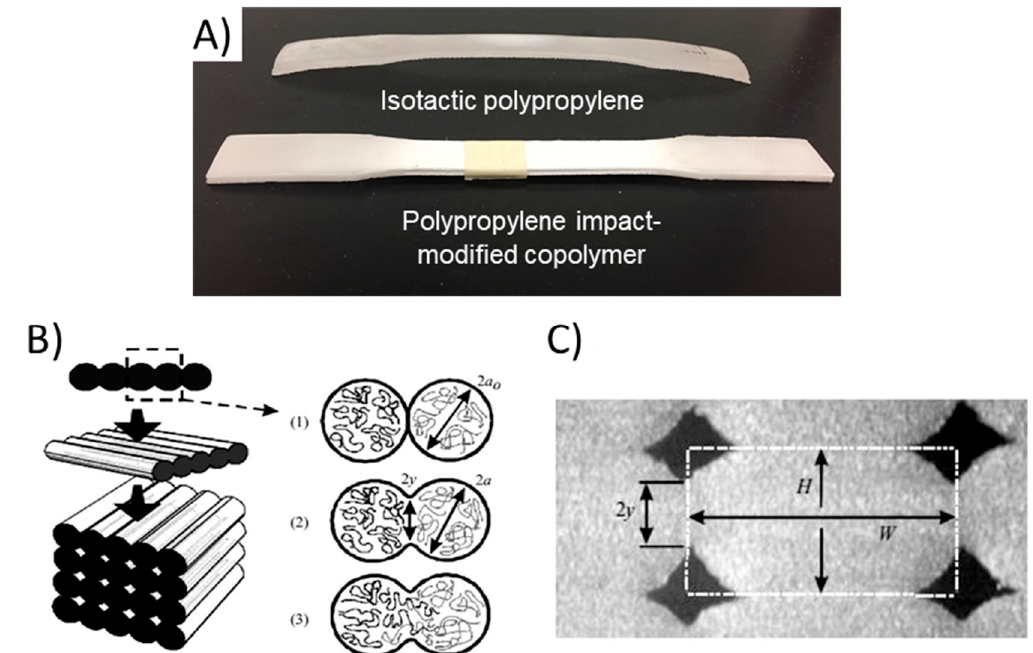
Figure 4. ( A ) Comparison of the dimensional stability of 3D printed PP and PP copolymer. Reprinted by permission from Springer [Journal of Thermal Analysis and Calorimetry. Ref. [64], copyright 2018] [64]. Schemes of ( B , C ) Bond formation process between two filaments: (1) surface contacting; (2) neck growth; (3) molecular di ff usion at interface and randomization. Reprinted from [17] with permission from Elsevier. Copyright (2017).